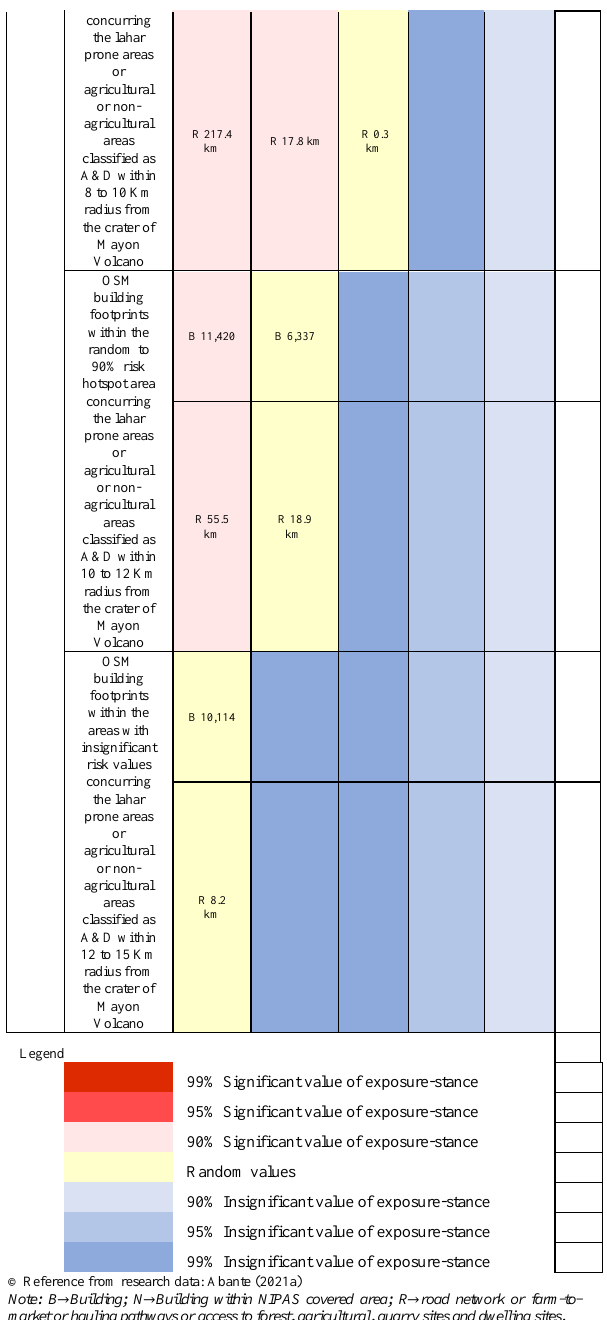
Table 4. Exposure-stance contextualization matrix Table 4 disclosed exposure-stances based on the five pairs of exposure-stances contexts that creates knowledge prompted by spatial information (nearness measurements) on accessibility, connectivity, proximity, risk reality, danger and hazards zones, and OSM roads and building footprints variables and